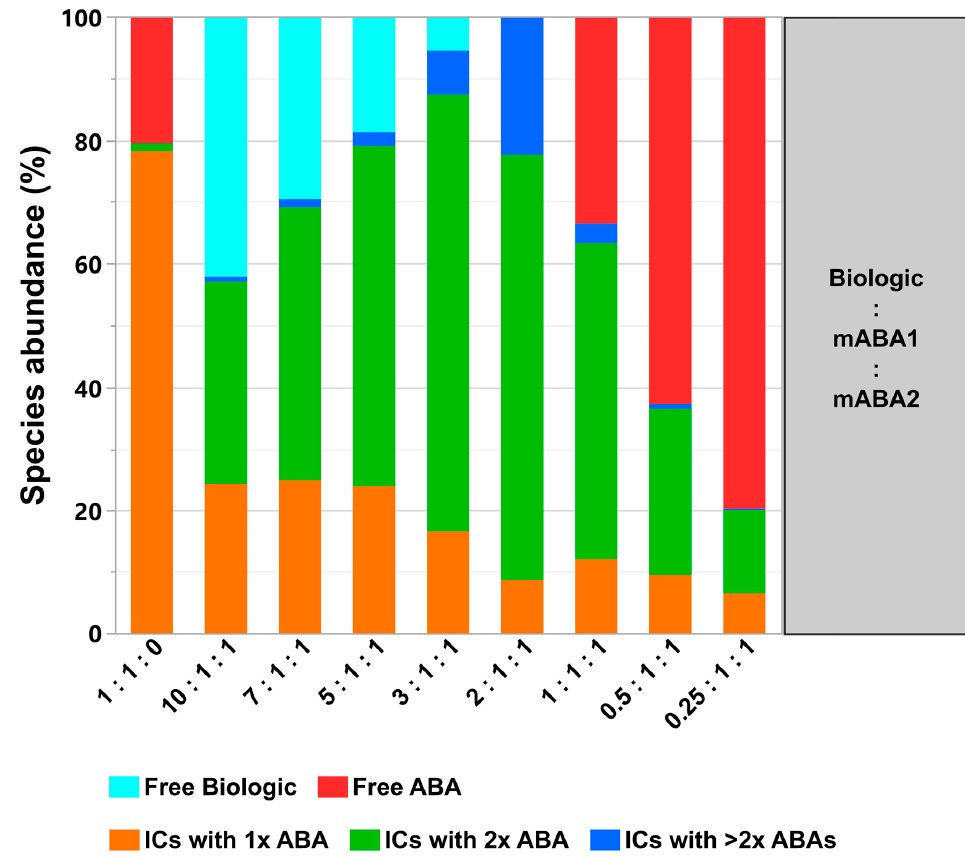
Figure 10. Quantification of formed immune complexes (ICs) between biologic and two monoclonal anti-biologic antibodies (mABAs). Quantitative SEC-MALS analysis read-out assessing relative levels of formed complexes and free components. Analyzed mixtures contain indicated molar ratios between biologic, mABA1, and mABA2 in PBS as